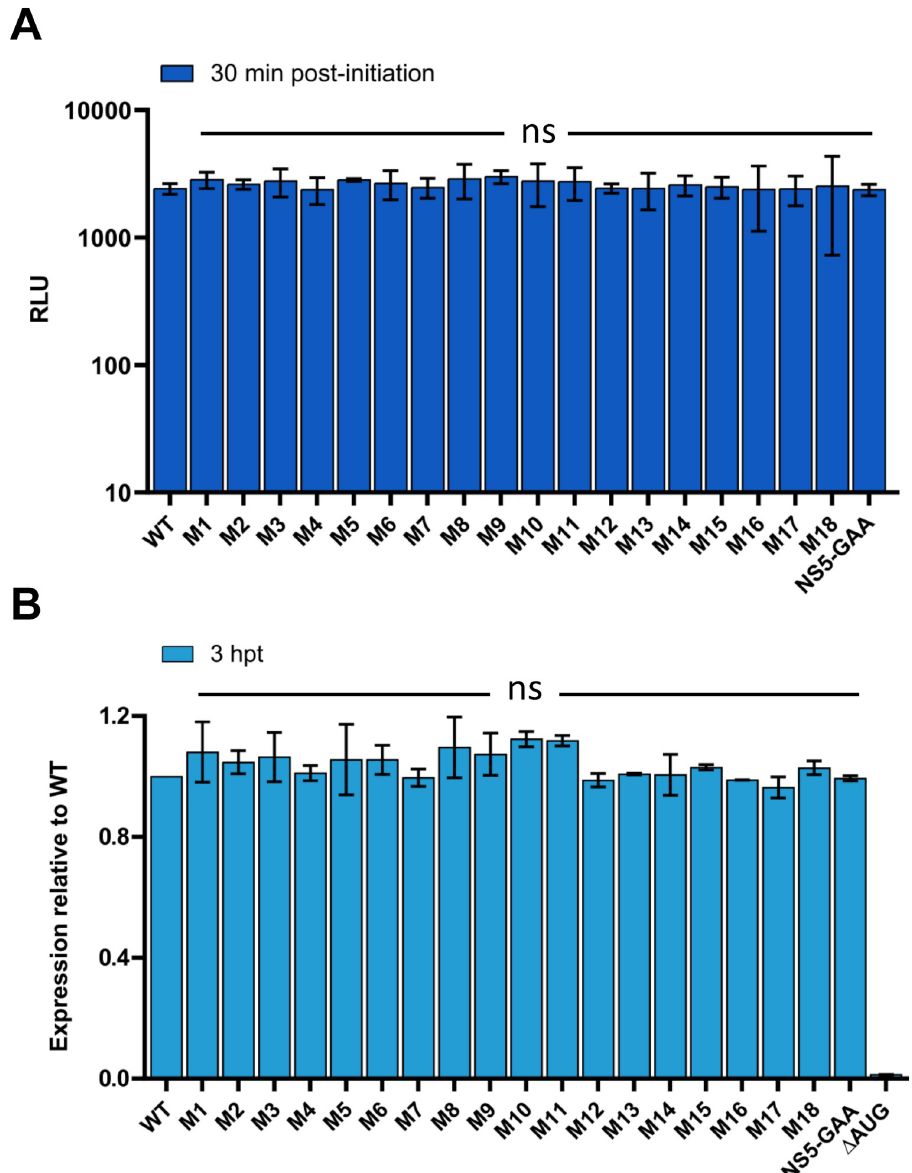
Fig 5. Translation of WT and SLA-mutant replicons. ( A ) Translation rates of 5 0 UTR mutants in cell-free translation assays 30 min post initiation. NS5-GAA RNA was evaluated as a negative control. ( B ) Translation of input mutant RNA in PS cells at 3 hpt. Normalized luciferase levels are shown relative to WT. Replication-competent NS5-GAA RNA and Δ AUG, evaluated as a negative control. Data were derived from three biological replicates; error bars show standard deviation. ns indicates no significant difference from WT. Data were analysed using a one-way Anova with Bonferroni’s correction. and M7 (at the base of S0), resulted in a significant attenuation of infectivity, which like WT virus, peaked at 24 hpi. In contrast, M11 showed delayed infectivity at 24 hpi. Further analysis using NS5 expression as a surrogate for virus infection (Fig 3A), revealed a delay in virus prop- agation in M11 compared with WT and M7/M14, indicating that SL1 is essential for the initia- tion of virus infectivity in vertebrate cells whilst SL2 is not. Mutations in S0 were lethal for